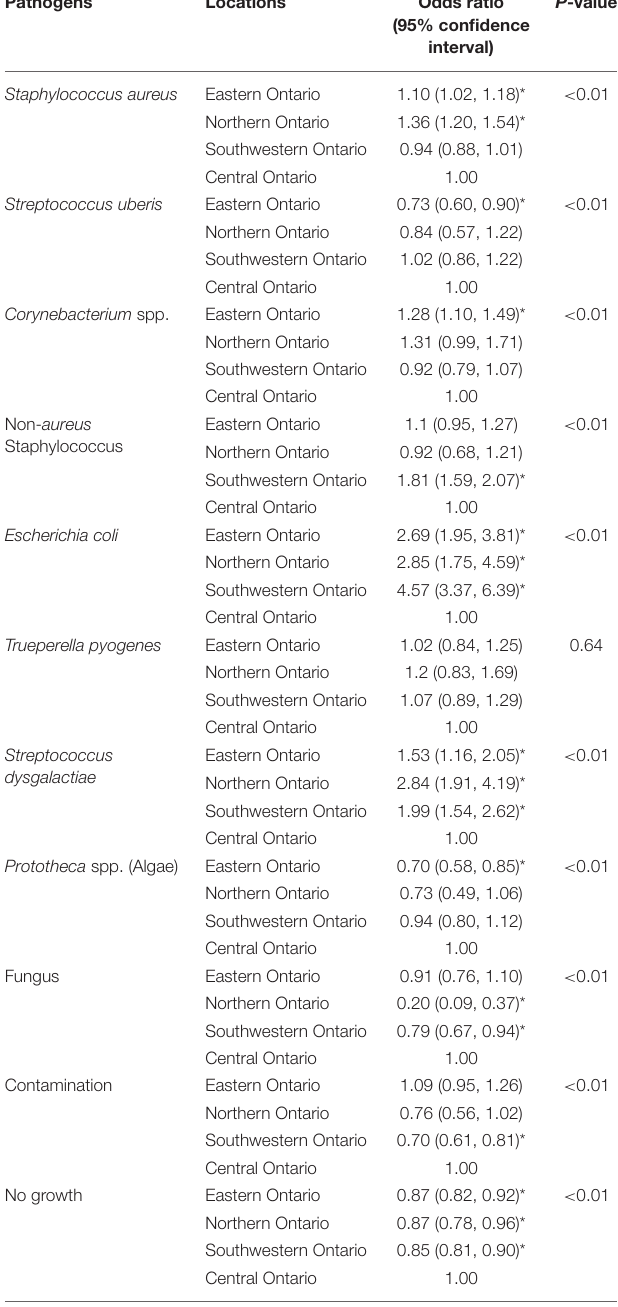
* Represent significant odds